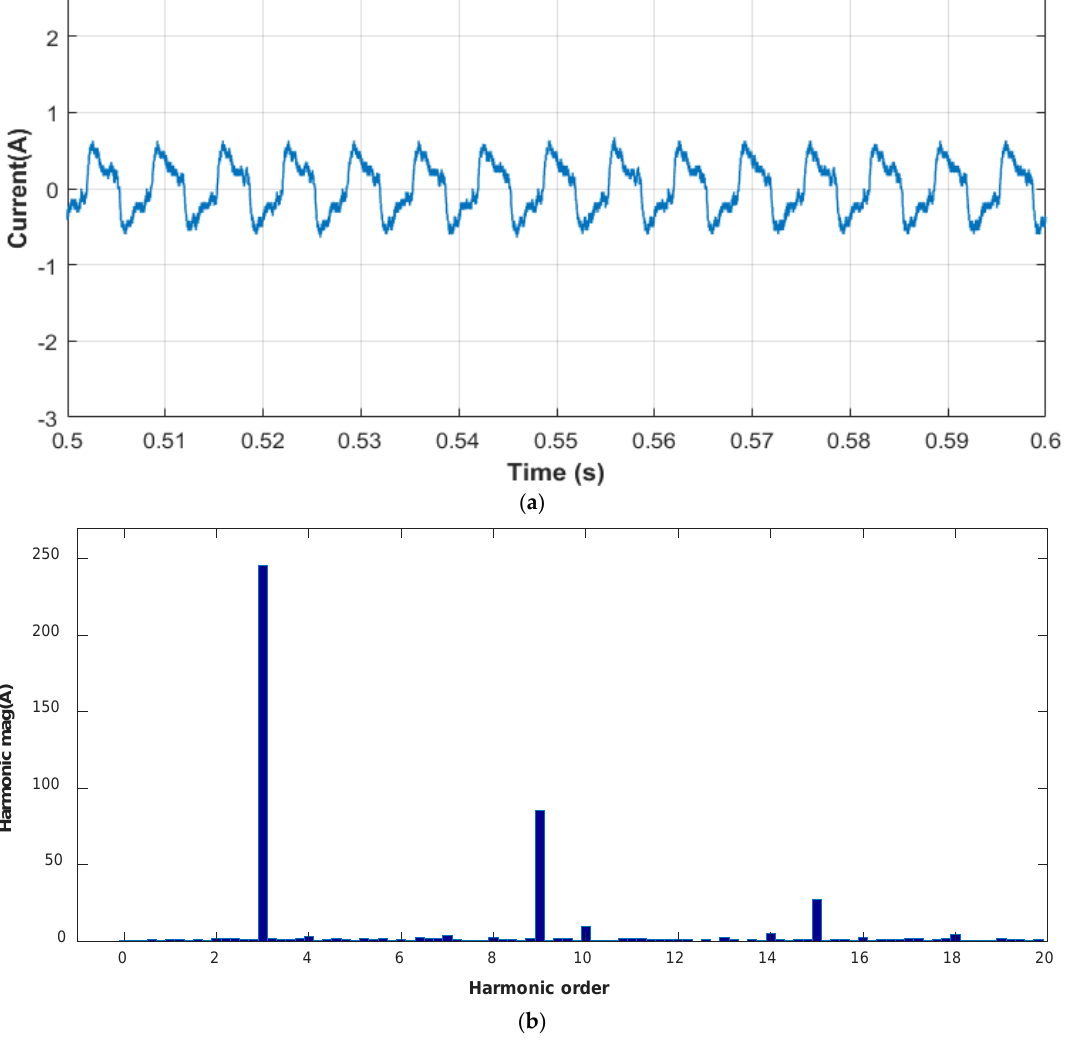
Figure 12. Simulation waveforms in parallel system with unequal inductance and with traditional proportional–integral (PI) suppression strategy: ( a ) ZSCC of system; ( b ) harmonics contained in ZSCC.